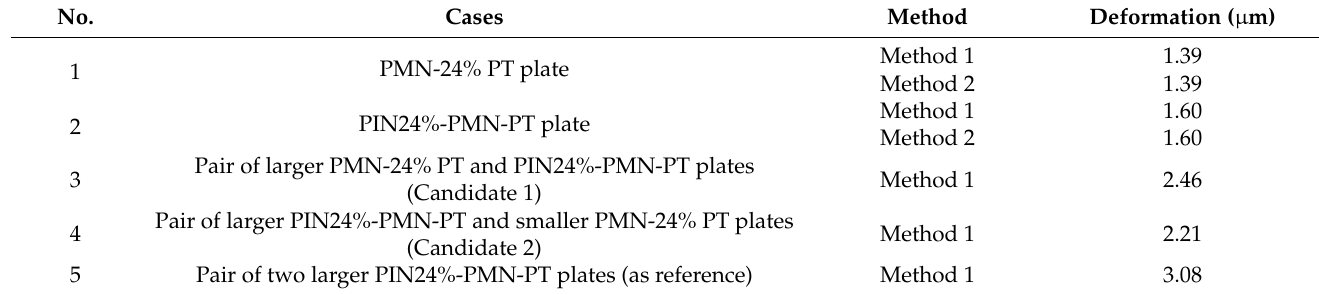
Figure 18. The “project schematic” of all the analyses carried out. Table 8. Static response analysis results of all